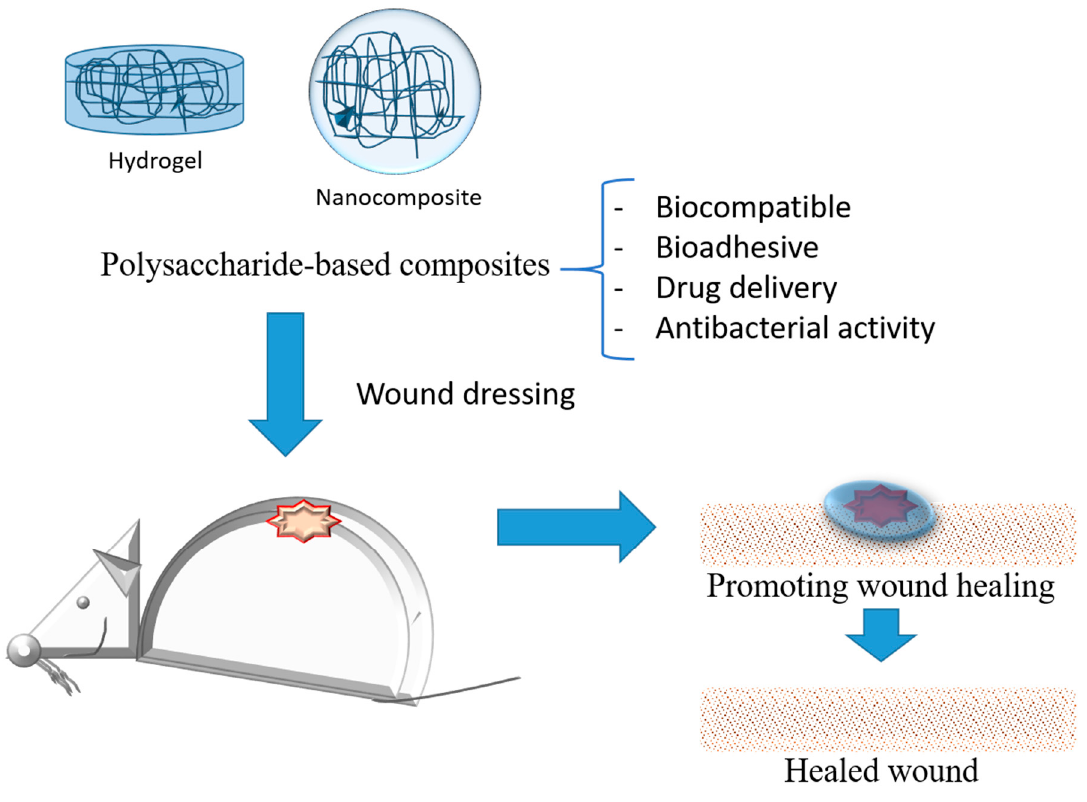
Figure 5. Schematic representation of polysaccharides-based composites applied as wound dressing for treatment.